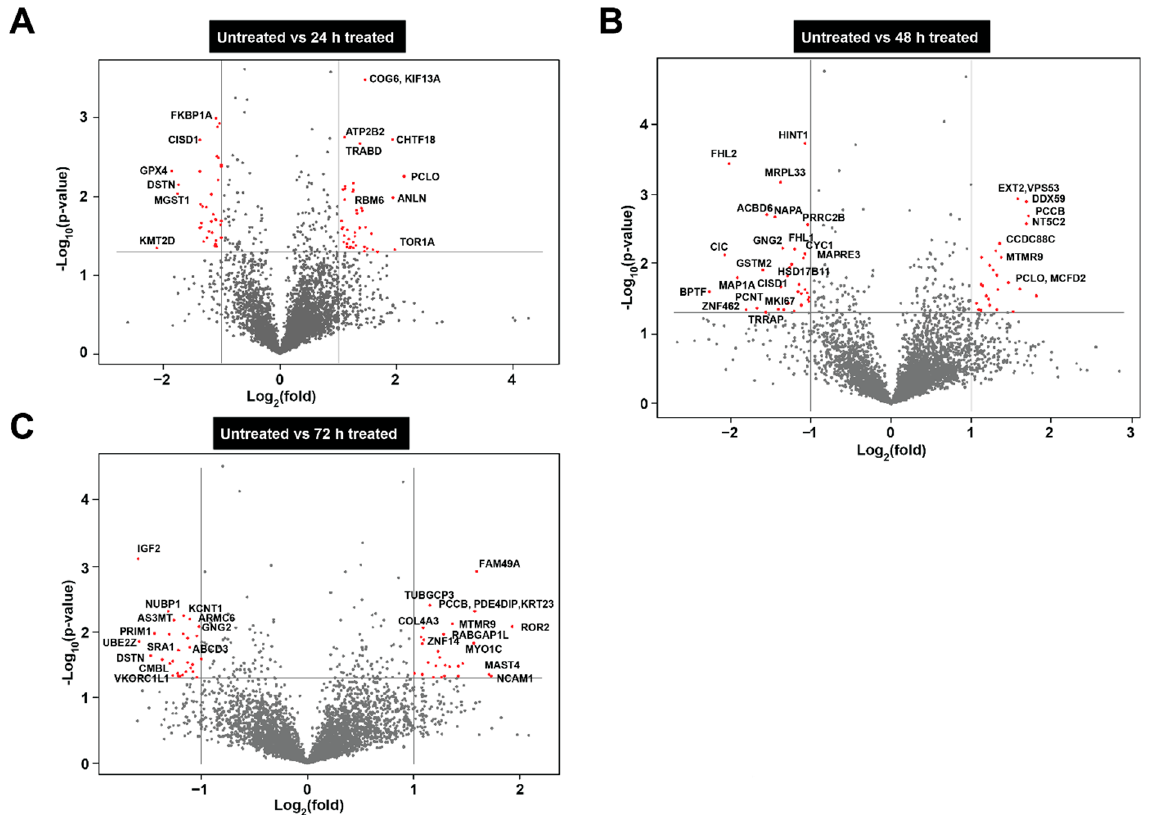
Figure 4. Depiction of differentially abundant proteins via volcano plots. ( A ) Volcano plot depicting the differential abundance of proteins in 24 h treated NBL cells compared to untreated. ( B ) Representation of differential abundance of proteins in 48 h treated NBL cells compared to untreated. ( C ) Volcano plot of differentially abundant proteins at 72 h. Y axis= p-value of the protein expression X axis = ±2-fold changed proteins.